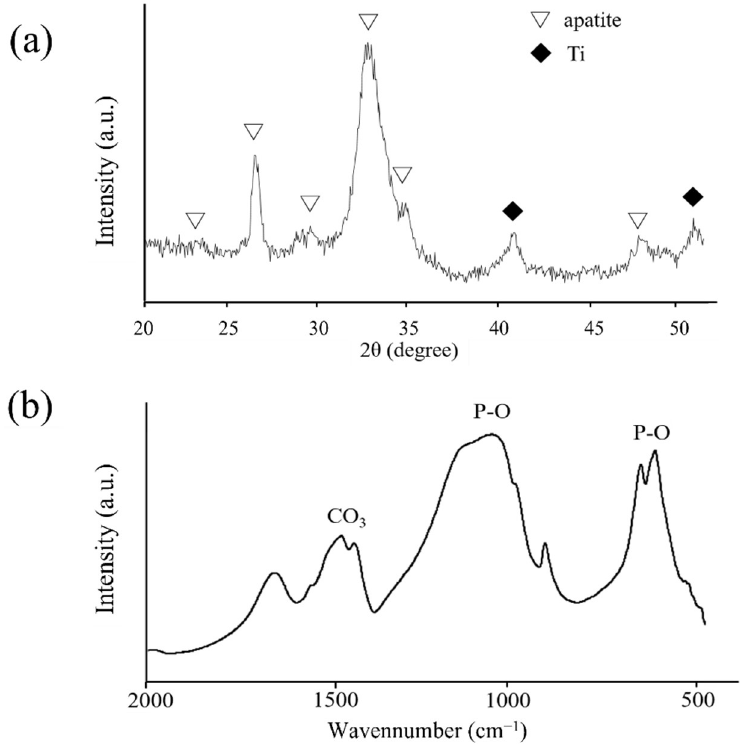
Figure 12. ( a ) XRD profiles of the deposited crystals on ZrO 2 /Ti disks after 14 days of HBSS immersion. ( b ) FT-IR spectrum of the deposited crystals on ZrO 2 /Ti disks after 14 days of HBSS immersion.